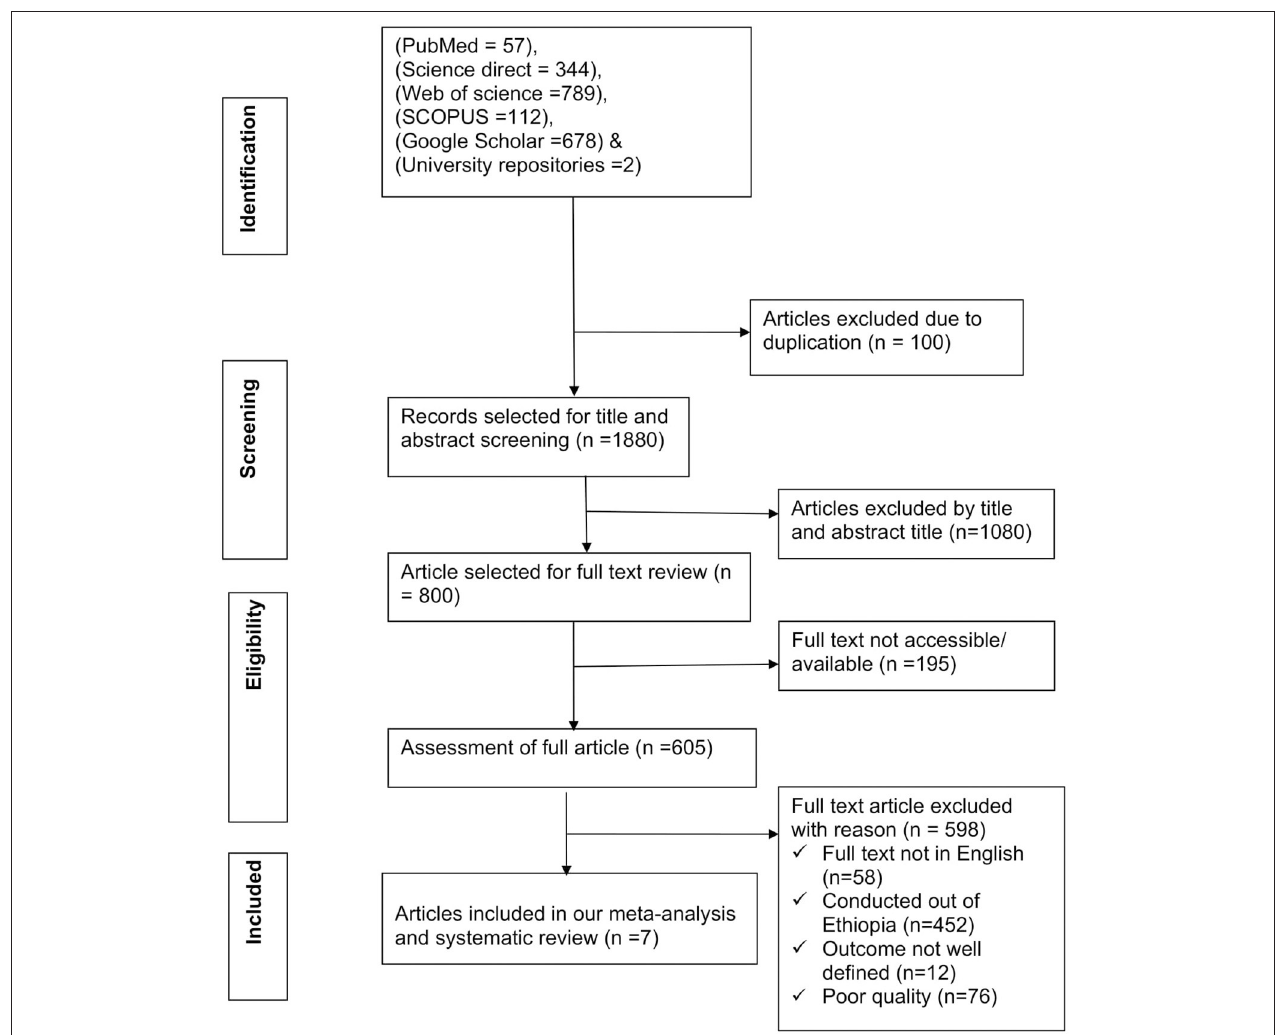
FIGURE 1 | PRISMA flow